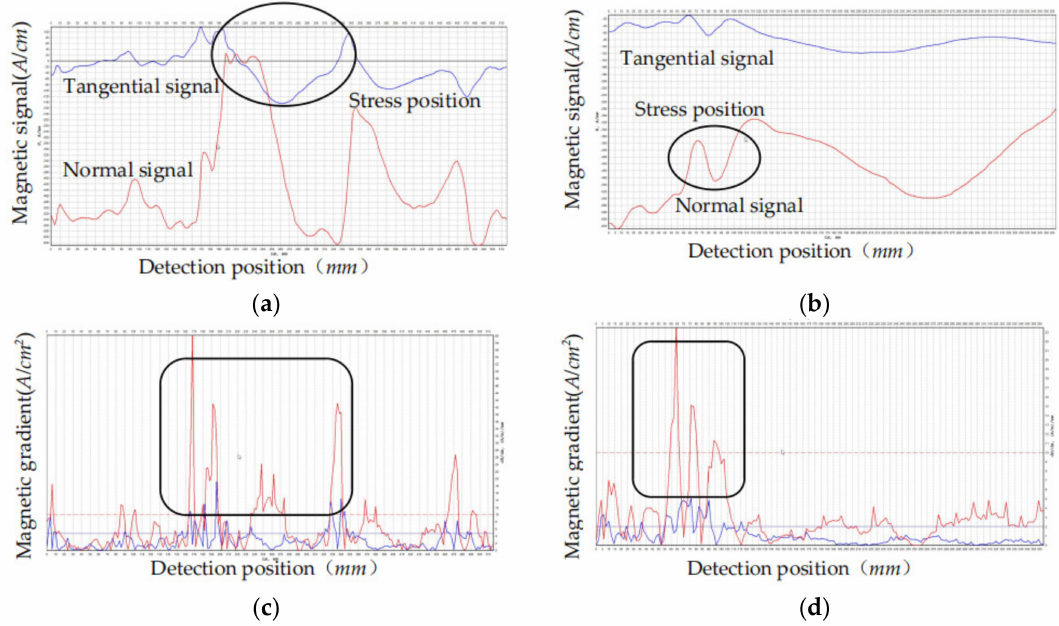
Figure 23. The magnetic memory measurement results: ( a ) Detection signal in region A; ( b ) Detection signal in region B; ( c ) Signal gradient in region A; ( d ) Signal gradient in region